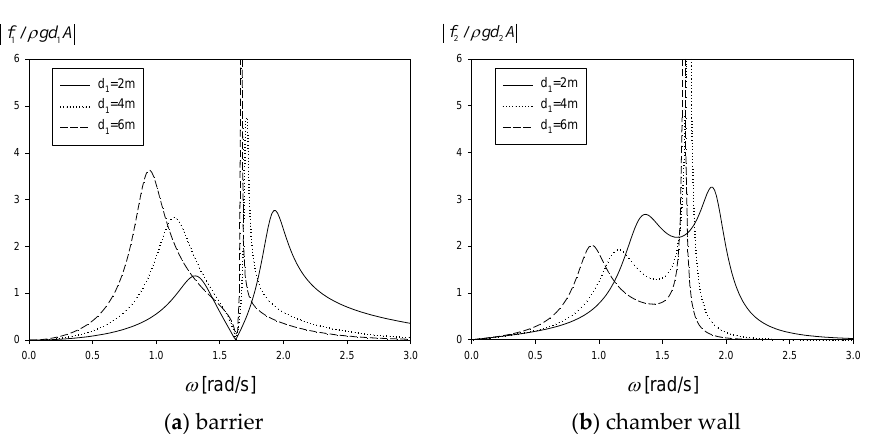
[rad/s] Figure 3. Induced flux by the incident waves ( a ), radiation conductance ( b ), and radiation admittance ( c ) as a function of the barrier height ( d 1 ) for h = 10 m, a = 3 m, d 2 = 3 m, b = 1.5 m. Figure 4 shows the non-dimensional wave forces on the barrier and chamber wall when the barrier height d 1 increases to 2, 4, and 6 m. As the barrier height increases, the wave force on the barrier increases, while the wave force on the chamber wall decreases by the effect of wave blocking by the barrier. The maximum wave forces occur at each resonance frequency. With an increase of the barrier height, the first resonant wave force on the barrier moves to the low-frequency region and increases, whereas the second resonant wave force shows the sharp reduction of resonant width.